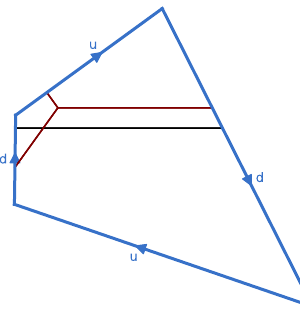
Figure 42 . A polygonal unknot L in M = R 3 . We show the projection to the x 1 - x 2 plane; the labels “u” and “d” (for “up” and “down”) next to link segments indicate how the segment is oriented in the x 3 -direction. We also show all possible BPS strings which can attach to L : there is one exchange (black) and one three-leaf web (dark red). The WKB foliations are as shown in figure 36.